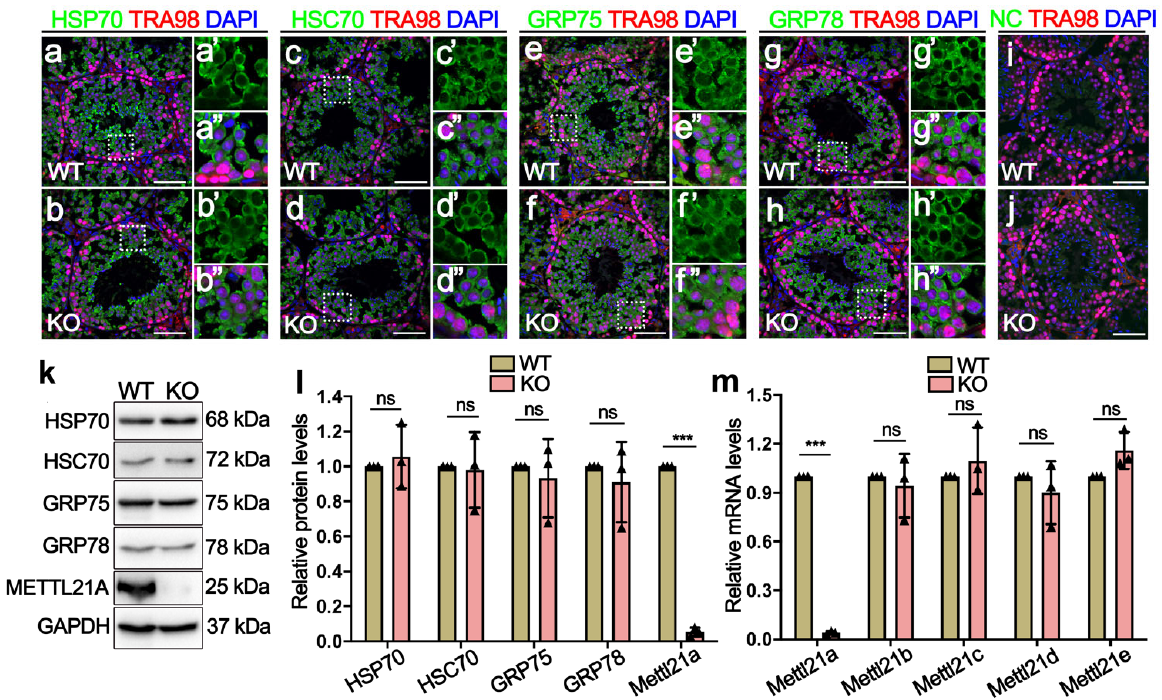
Figure 4. Mettl21a deletion does not affect the temporal and spatial expression of its target proteins. ( a – h’’ ) Co ‐ immunofluorescence staining of TRA98 and HSP70 ( a , b ), HSC70 ( c , d ), GRP75 ( e , f ), and GRP78 ( g , h ), respectively, in P56 WT and KO testes. Scale bar = 50 μ m. Magnified images ( a’ , a’’ , b’ , b’’ , c’ , c’’ , d’ , d’’ , e’ , e’’ , f’ , f’’ , g’ , g’’ , h’ , h’’ ) of white boxes in ( a – h ), further highlight the expression and localization of HSP70, HSC70, GRP75, and GRP78 in WT and KO testes, respectively. ( i , j ) Negative control (NC) omitting the primary antibody to detect the specificity of the immunostaining with Alexa 488. Germ cells show unspecific staining. Germ cell were stained with anti ‐ TRA98 antibody. Nuclei were stained with DAPI. Scale bars = 50 μ m. ( k ) Western blot showing the expression of HSP70, HSC70, GRP75, GRP78, and METTL21A in P56 WT and KO testes. GAPDH was used as a loading control. ( l ) Quantification of relative indicated protein levels of B, respectively. Data are presented as mean ± SEM, n = 3. ns, not significant. *** p < 0.001 by student’s t ‐ test. ( m ) RT ‐ qPCR shows the mRNA levels of five members of the Mettl21 family in adult WT and KO testes. Data are presented as mean ± SEM, n = 3. ns, not significant. *** p < 0.001 by student’s t ‐ test.